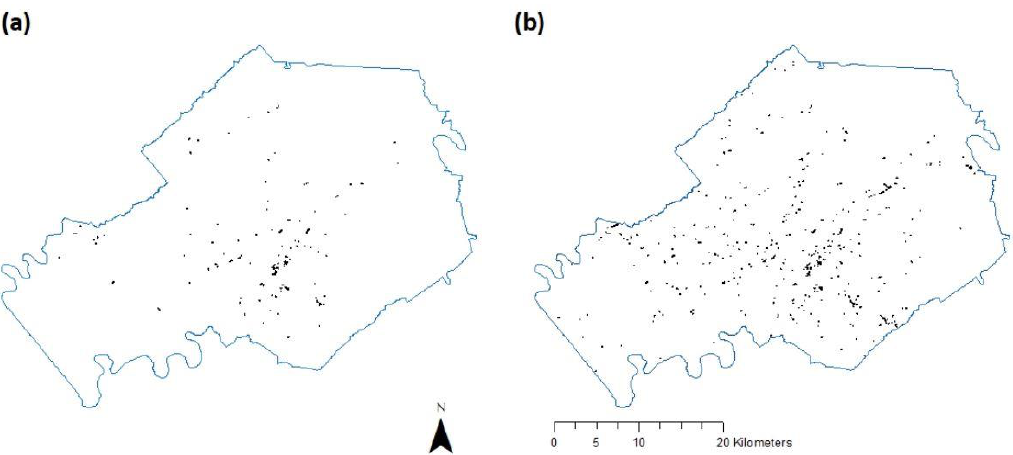
Figure 4. ( a ) 320 kudzu training samples, and ( b ) 1010 predicted kudzu objects in Figure 4. (a) 320 kudzu training samples, and (b) 1010 predicted kudzu objects in Knox County by support vector machine using the proposed workflow with 3% omission rate at the first-step classification.